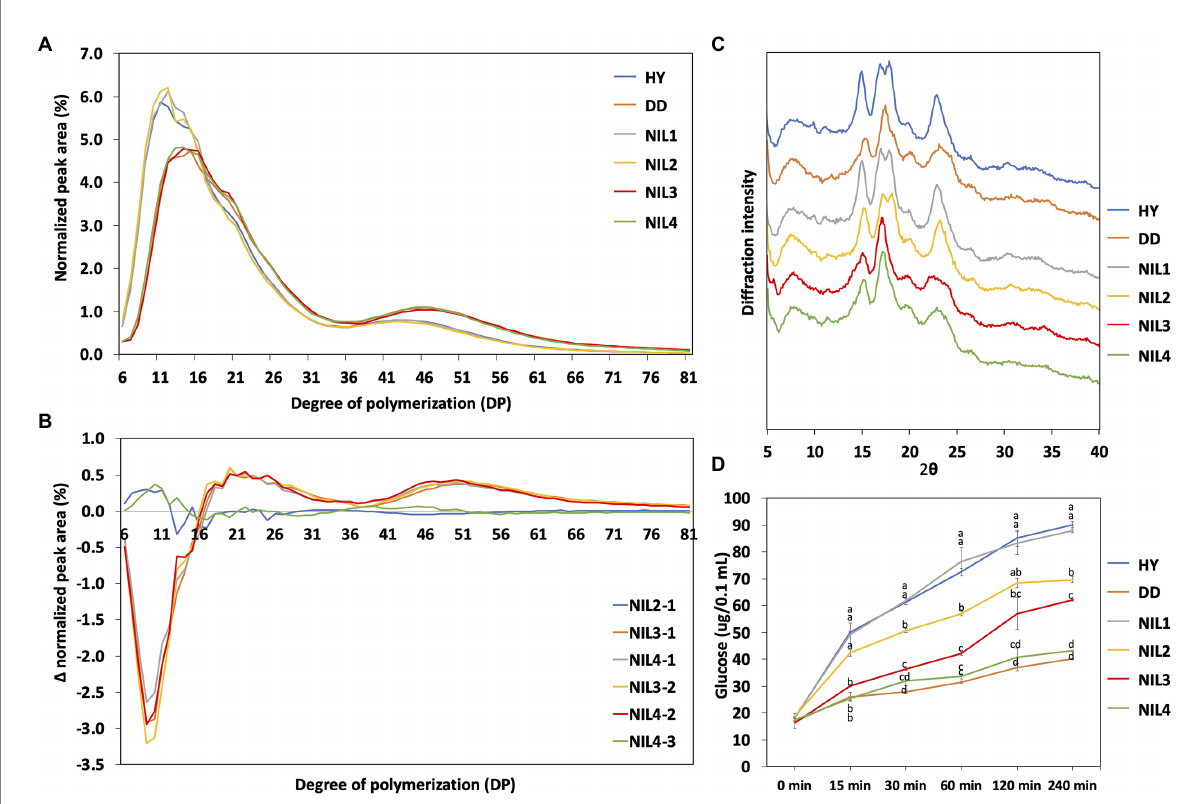
FIGURE 3 Physico-chemical characteristics of four NILs. (A) Chain length distribution of the two parental lines and four NILs. (B) Differences in the molecular structure of amylopectin between the four NILs. Differences are shown as Δ (Delta) normalized peak area. (C) X-ray diffraction pattern of rice starch samples. (D) Starch digestibility analysis of the two parental lines and four NILs. Glucose content was determined by GOPOD kit (Megazyme Co., Wicklow, Ireland) from the digestion of each starch sample. The same letter is not significantly different at p = 0.05 based on Tukey’s test. HY, Hwayeong; DD, Dodamssal.